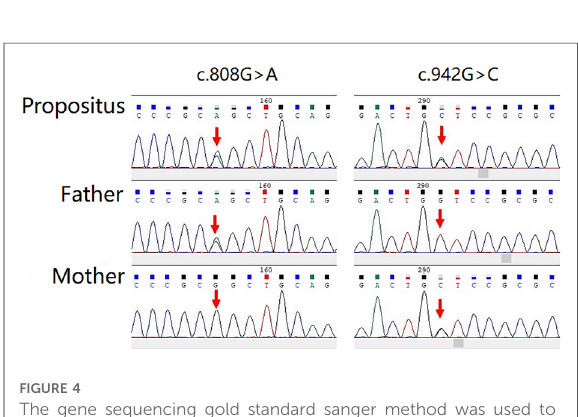
FIGURE 4 The gene sequencing gold standard sanger method was used to verify the mutation, and it was found that the child showed mutation at the loci of the suspected